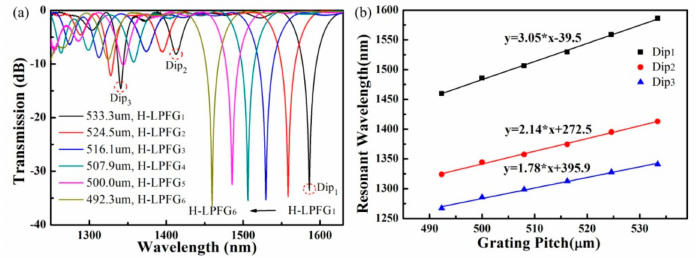
Figure 13. ( a ) Transmission spectra of six HLPFGs in SMF with di ff erent helical grating pitches; ( b ) measured resonant wavelength of the HLPFG versus helical grating pitch [13].